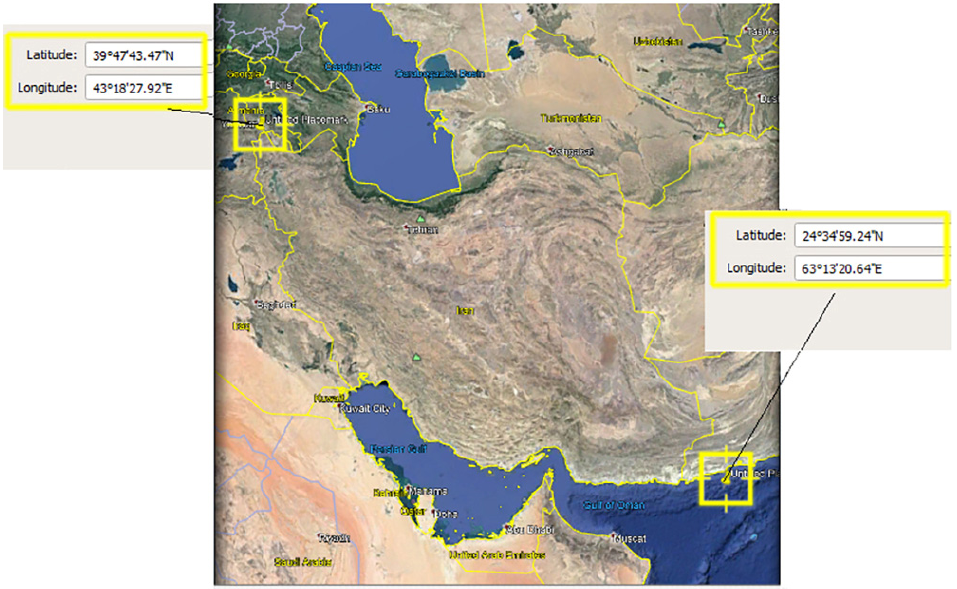
Figure 1. Iran upper left and lower right geographical coordinates (Google Earth).